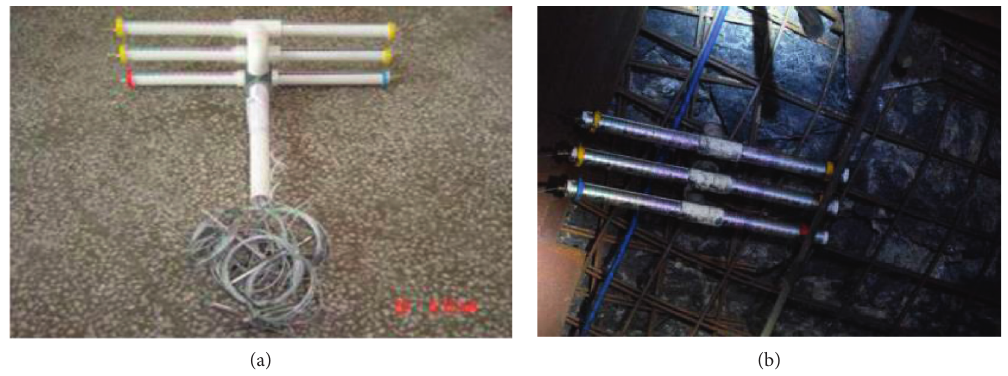
Figure 8: KDW-2 displacement meter at the roof: (a) displacement meter; (b) installation at the